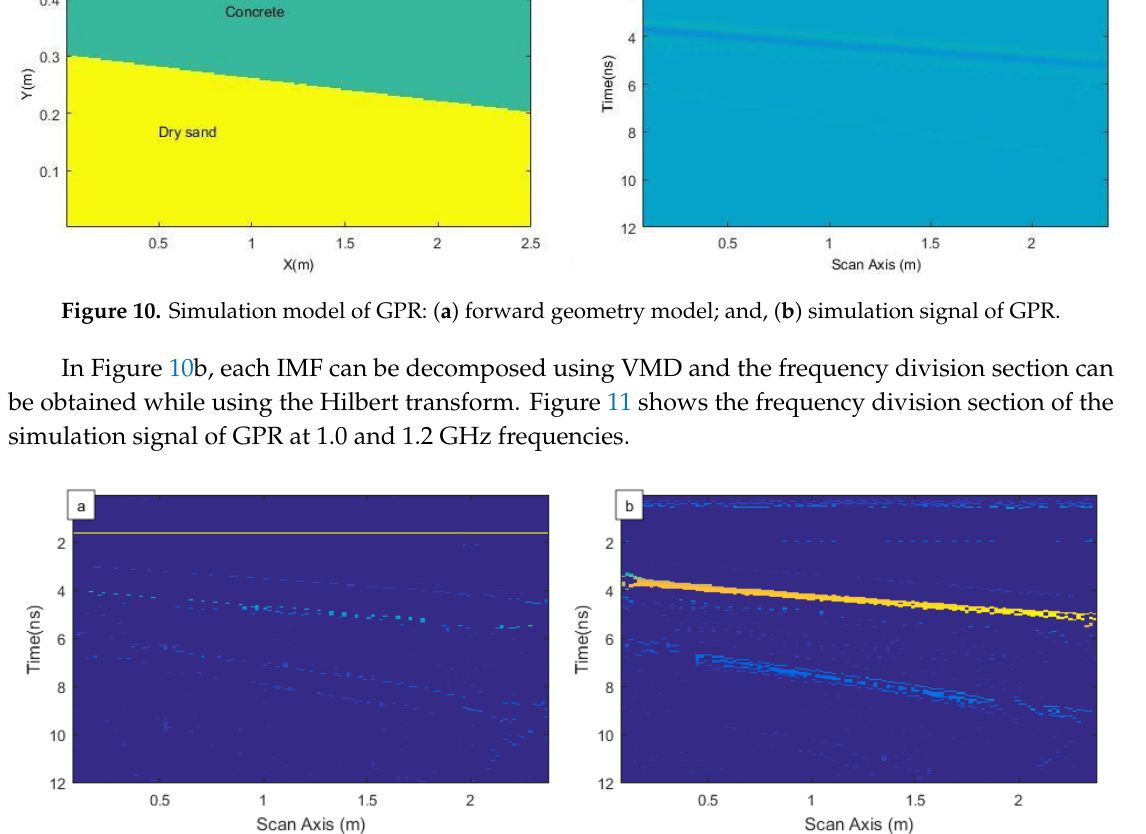
Figure 11. Frequency division section based on VMD: ( a ) frequency division section at 1.0 GHz; and, ( b ) frequency division section at 1.2 GHz.